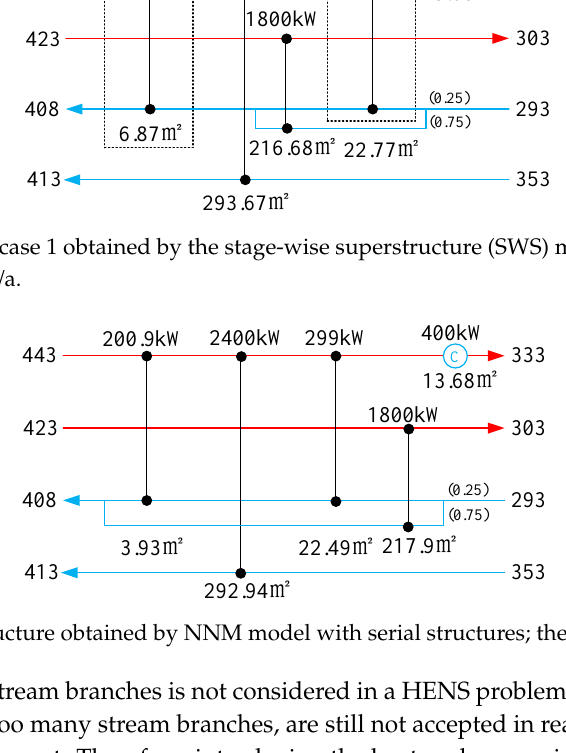
Figure 4. The structure obtained by NNM model with serial structures; the TAC is 77,048 $/a.